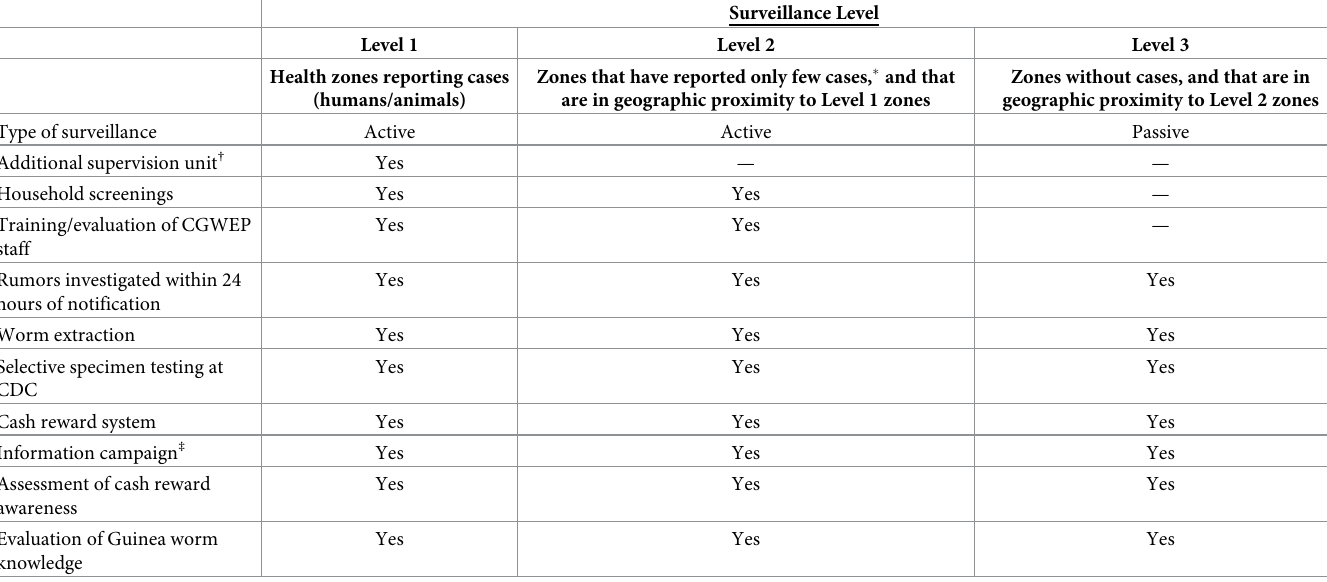
Table 1. Chad Guinea Worm Eradication Program surveillance